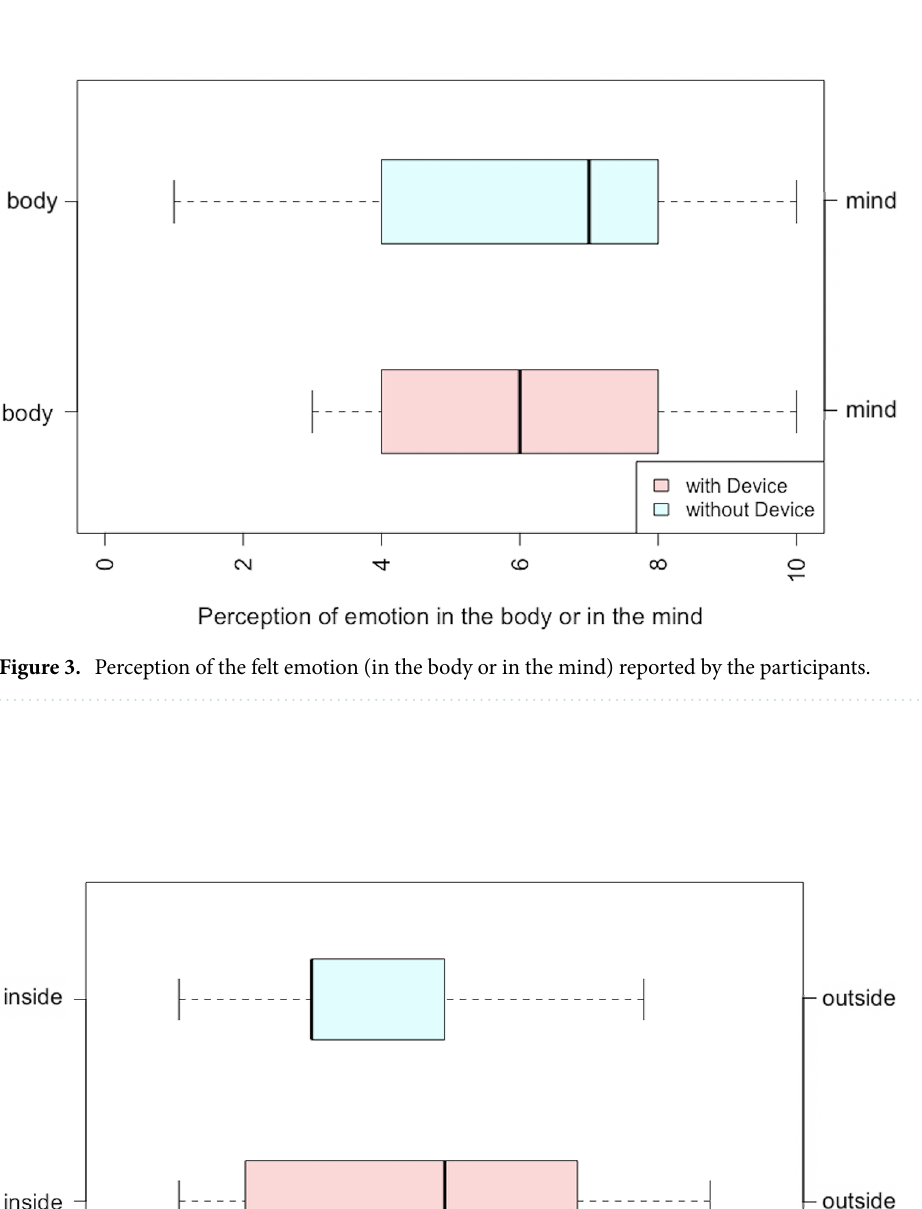
Table 2. Comparison of the viewer’s confidence regarding understanding of the stimulus, perception of emotion generation inside or outside the body, and perception of emotion felt in the body or the mind across device conditions.